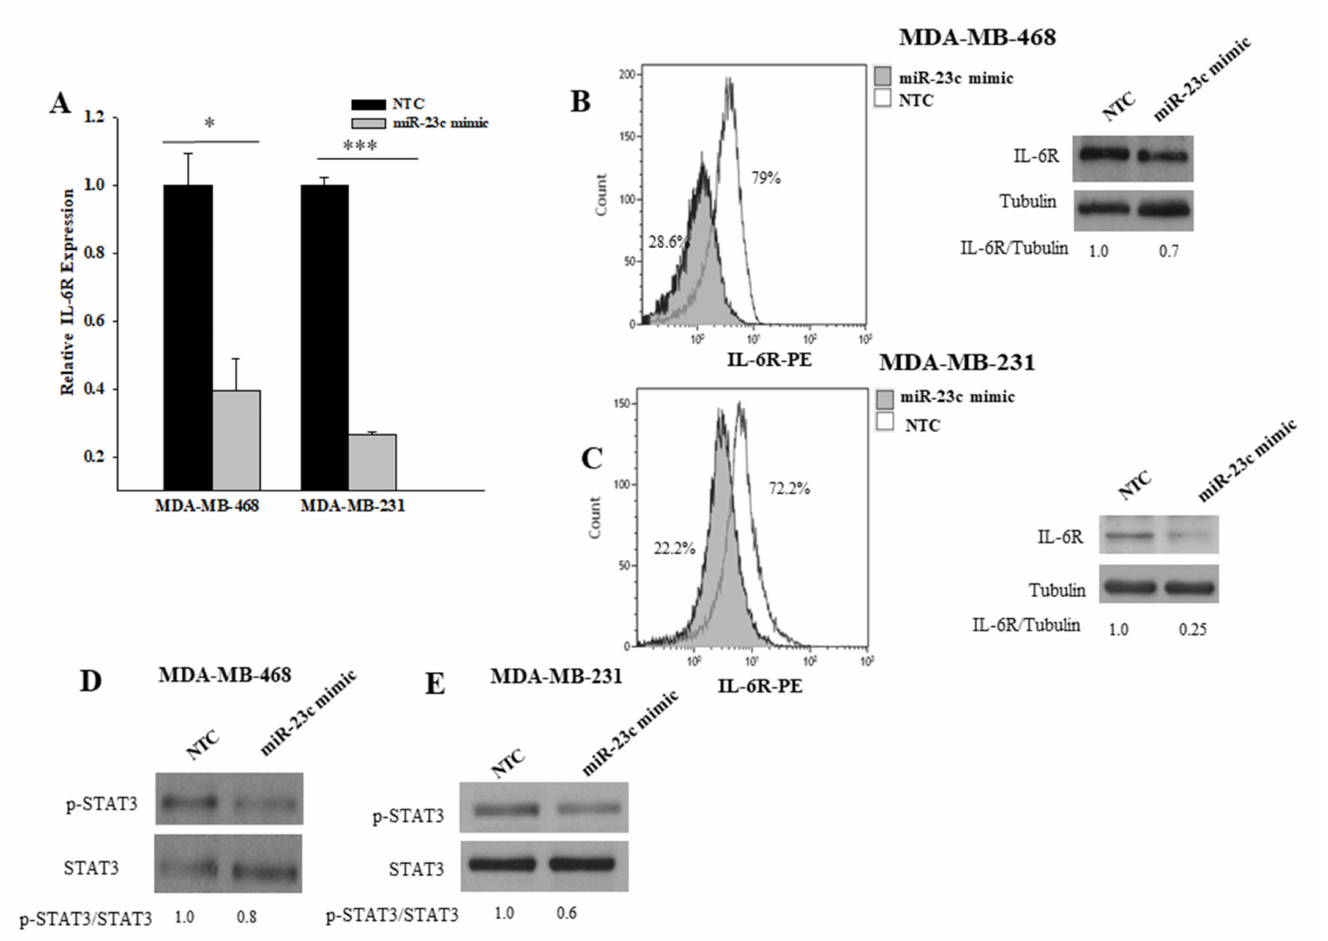
Figure 7. Effects of miR-23c on IL-6R expression and downstream signaling proteins. ( A ) The transcript of IL-6R in MDA-MB-231 and MDA-MB-468 cells, transfected with the miR-23c mimic or the non-targeting control (NTC), was measured by Real-time PCR (* p ≤ 0.05 and *** p ≤ 0.001; Students t -test). ( B ) Cytofluorimetric and Western blot analysis of IL-6R protein in MDA-MB- 468 cells transfected with the miR-23c mimic or the NTC. Blot was normalized with the α -tubulin antibody. Quantification was performed using densitometric analysis. Densitometric value ratios for IL-6R/tubulin are shown. ( C ) Cytofluorimetric and Western blot analysis of IL-6R protein in MDA-MB-231 cells transfected with the miR-23c mimic or the NTC. Densitometric value ratios for IL-6R/tubulin are shown. Western blot analysis of activated form of STAT3 in MDA-MB-468 ( D ) and MDA-MB-231 cells ( E ) transfected with the miR-23c mimic or the NTC. Blots were normalized